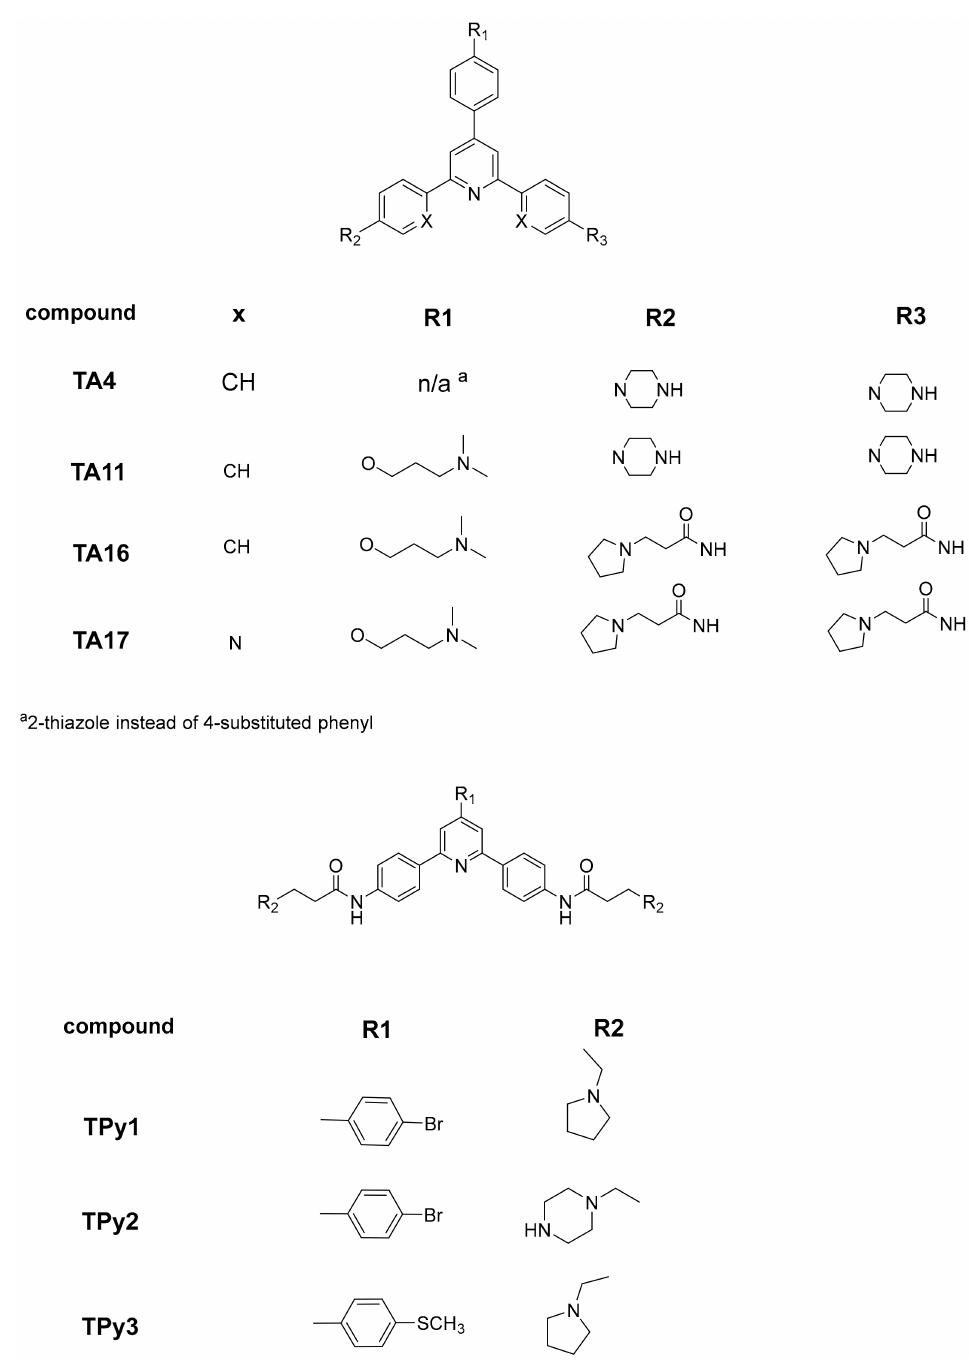
Figure 19. Structures of triarylpyridines and